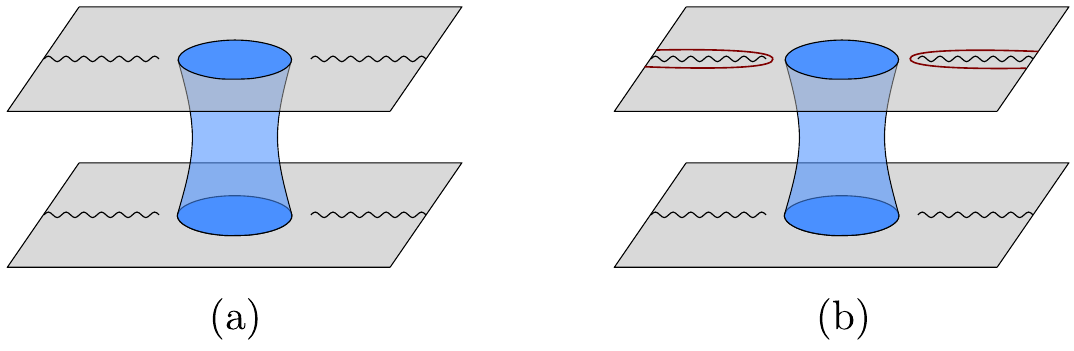
Figure 5 . (a) The replica wormhole geometry M 2 for computing Z 2 (0) . (b) For Z 2 ( α ) , we have the symmetry transformation operators inserted around the cuts in one of the